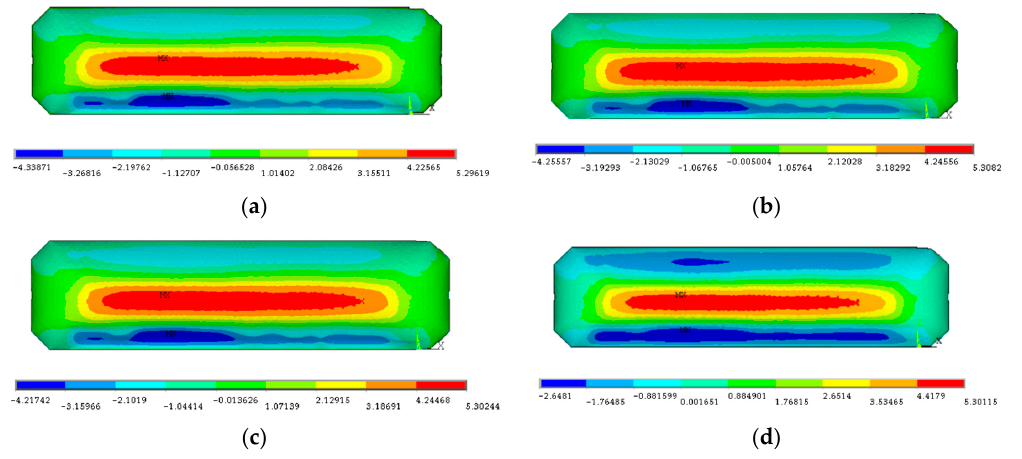
Figure 10. Cloud chart of z -component membrane surface displacement (unit: m): ( a ) μ = 0.2; ( b ) μ = 0.44; ( c ) μ = 0.68; and ( d ) μ = ∞ *.